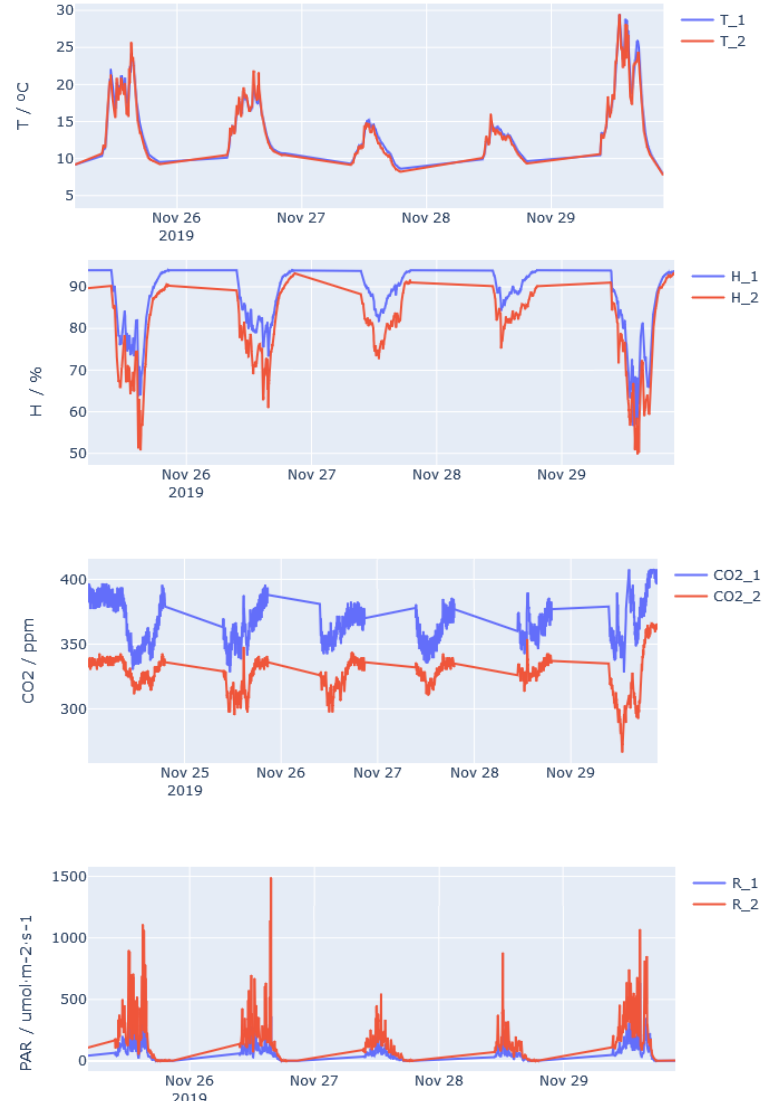
Figure 13. Evolution after planting of temperature, relative humidity, CO 2 concentration and PAR radiation (1: PV glass, 2: conventional glass).